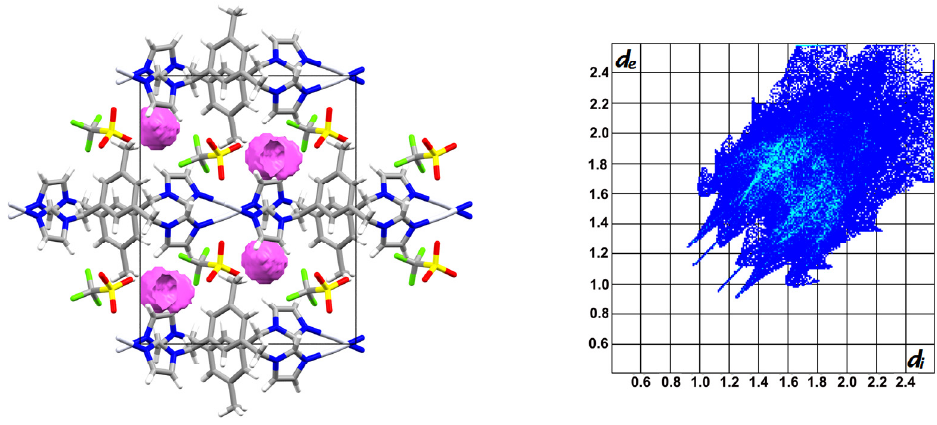
Figure 7. Schematic representation of the crystal packing in 4 shown down the c axis, with free space indicated in pink ( left ); fingerprint plot for 4 ( right ).